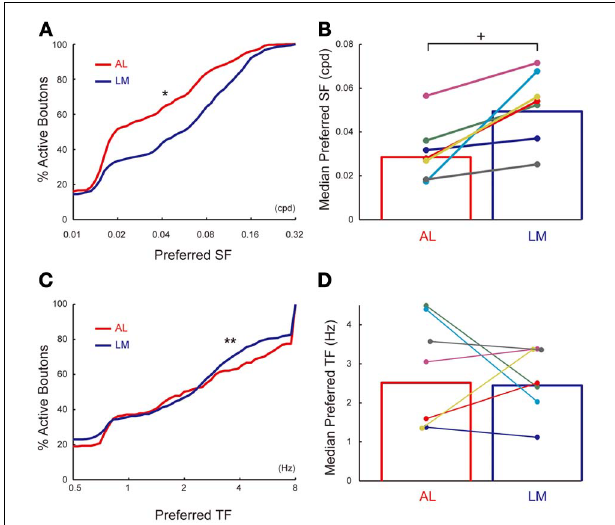
FIGURE 6 | SF and TF tuning properties of axonal boutons in AL and LM. (A) Cumulative distributions of preferred SF in AL and LM. Mean of preferred SF across all boutons = 0.031 and 0.048cpd for AL and LM, respectively. ∗ , P < 0 . 001. (B) Mean preferred SF in AL and LM for each animal. Each pair of colored dots indicates data from one animal. Mean of preferred SF across all animals = 0.029 and 0.049 cpd for AL and LM, respectively. Bar graph shows mean of all the animals. + , P < 0 . 01. (C) Cumulative distributions of preferred TF in AL and LM [same set of boutons as in (A) ]. Mean of preferred TF across all boutons = 2.1 and 1.9Hz for AL and LM, respectively. ∗∗ , P < 0 . 03. (D) Mean preferred TF in AL and LM for each animal. Mean of preferred TF across all animals = 2.5 and 2.4Hz for AL and LM, respectively. Each pair of colored dots indicates data from one animal. Bar graph shows mean of all the